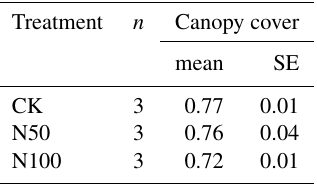
Table 2. The indicator of canopy cover (i.e. [1 − Fmv]) of the three treatments in our experiments. n indicates the number of replicates. SE indicates the standard